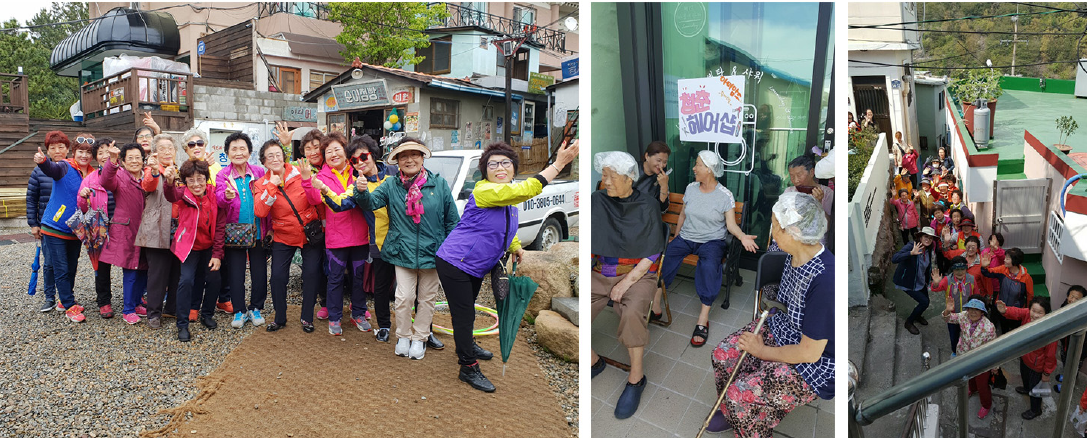
Figure 4. Other programs organized by Ami-Moms in the village.